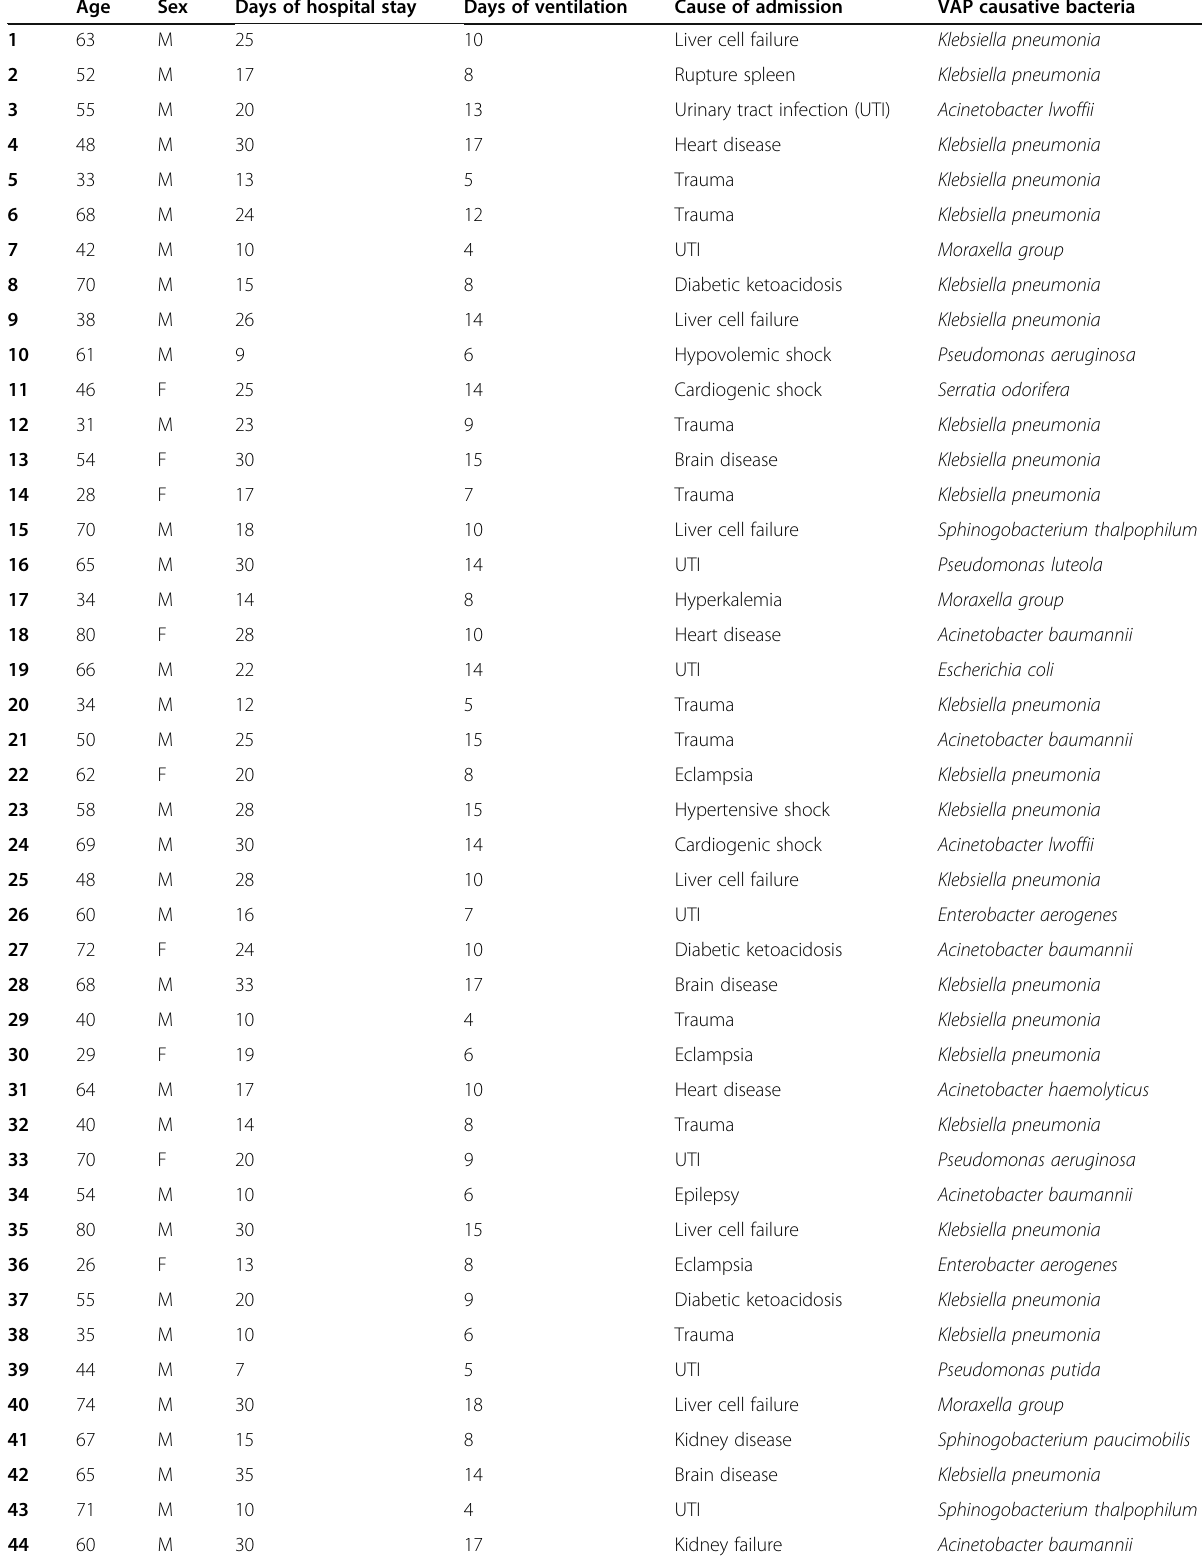
Table 1 Demographic data of VAP patients admitted to ICU of BSU